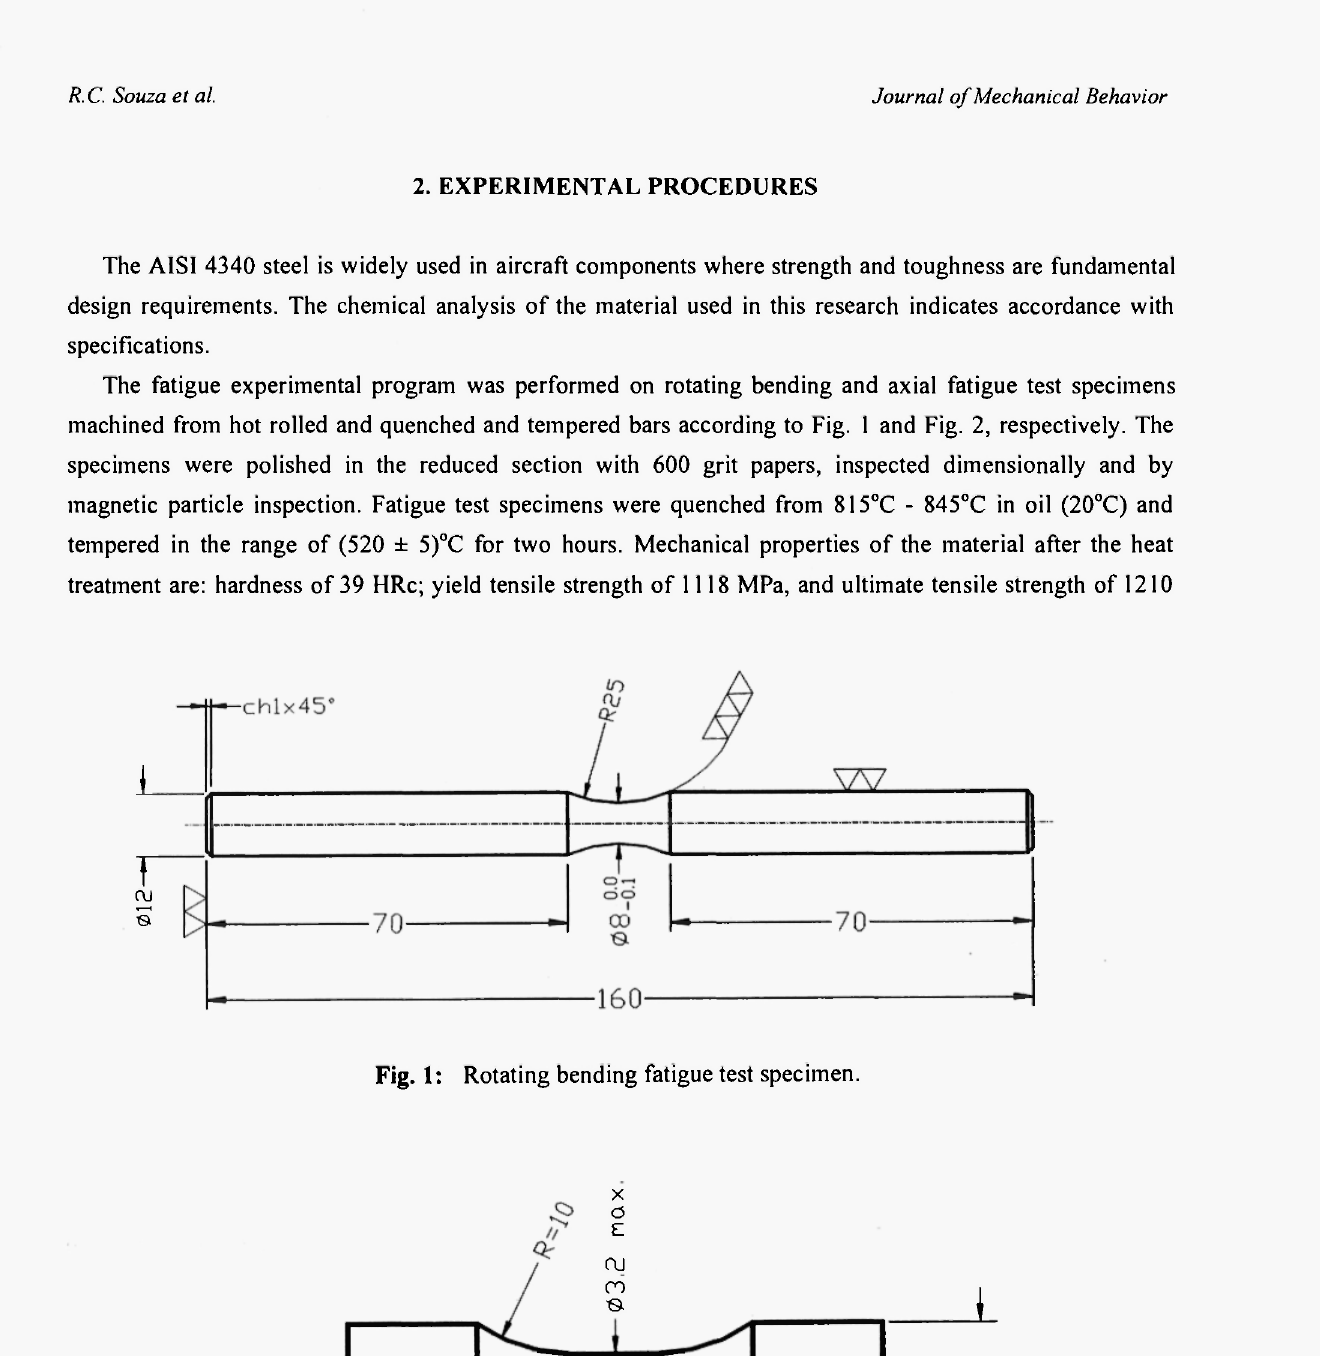
Fig. 1: Rotating bending fatigue test specimen.